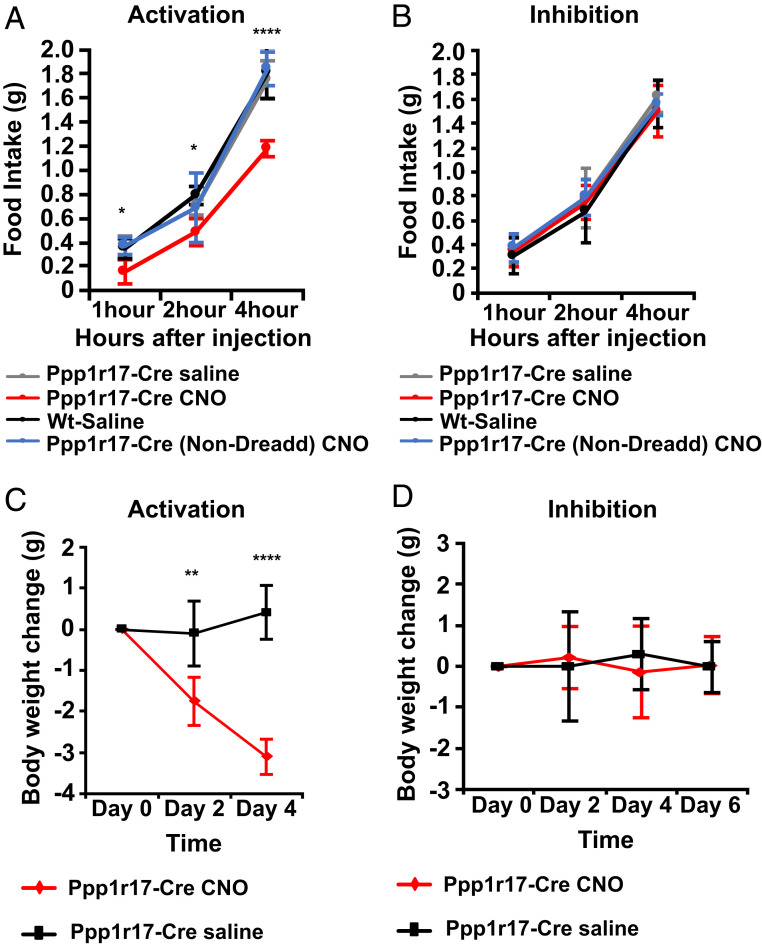
Effect of chemogenetic modulation of DMHPpp1r17 neurons on food intake and body weight in WT mice. (A) Chemogenetic activation of DMHPpp1r17 neurons using AAV8-hSyn-DIO-hM3D(Gq)-mCherry. DREADD-induced activation of DMHPpp1r17 neurons significantly decreases food intake over the course of 4 h. (B) Chemogenetic inhibition of DMHPpp1r17 neurons using AAV8-hSyn-DIO-hM4D(Gi)-mCherry. DREADD-induced inhibition of DMHPpp1r17 neurons does not affect food intake over the course of 4 h. (C) Body weight of Ppp1r17-Cre mice is significantly reduced after chronic activation of DMHPpp1r17 neurons by i.p. injection of CNO two times per day. (D) Body weight of Ppp1r17-Cre mice does not significantly change after chronic inhibition of DMHPpp1r17 neurons by i.p. injection of CNO two times per day (*P < 0.05, **P < 0.01, ***P < 0.001, and ****P < 0.0001, two-tailed unpaired t test; n = 5 to 6 mice). All error bars are mean ± SD.